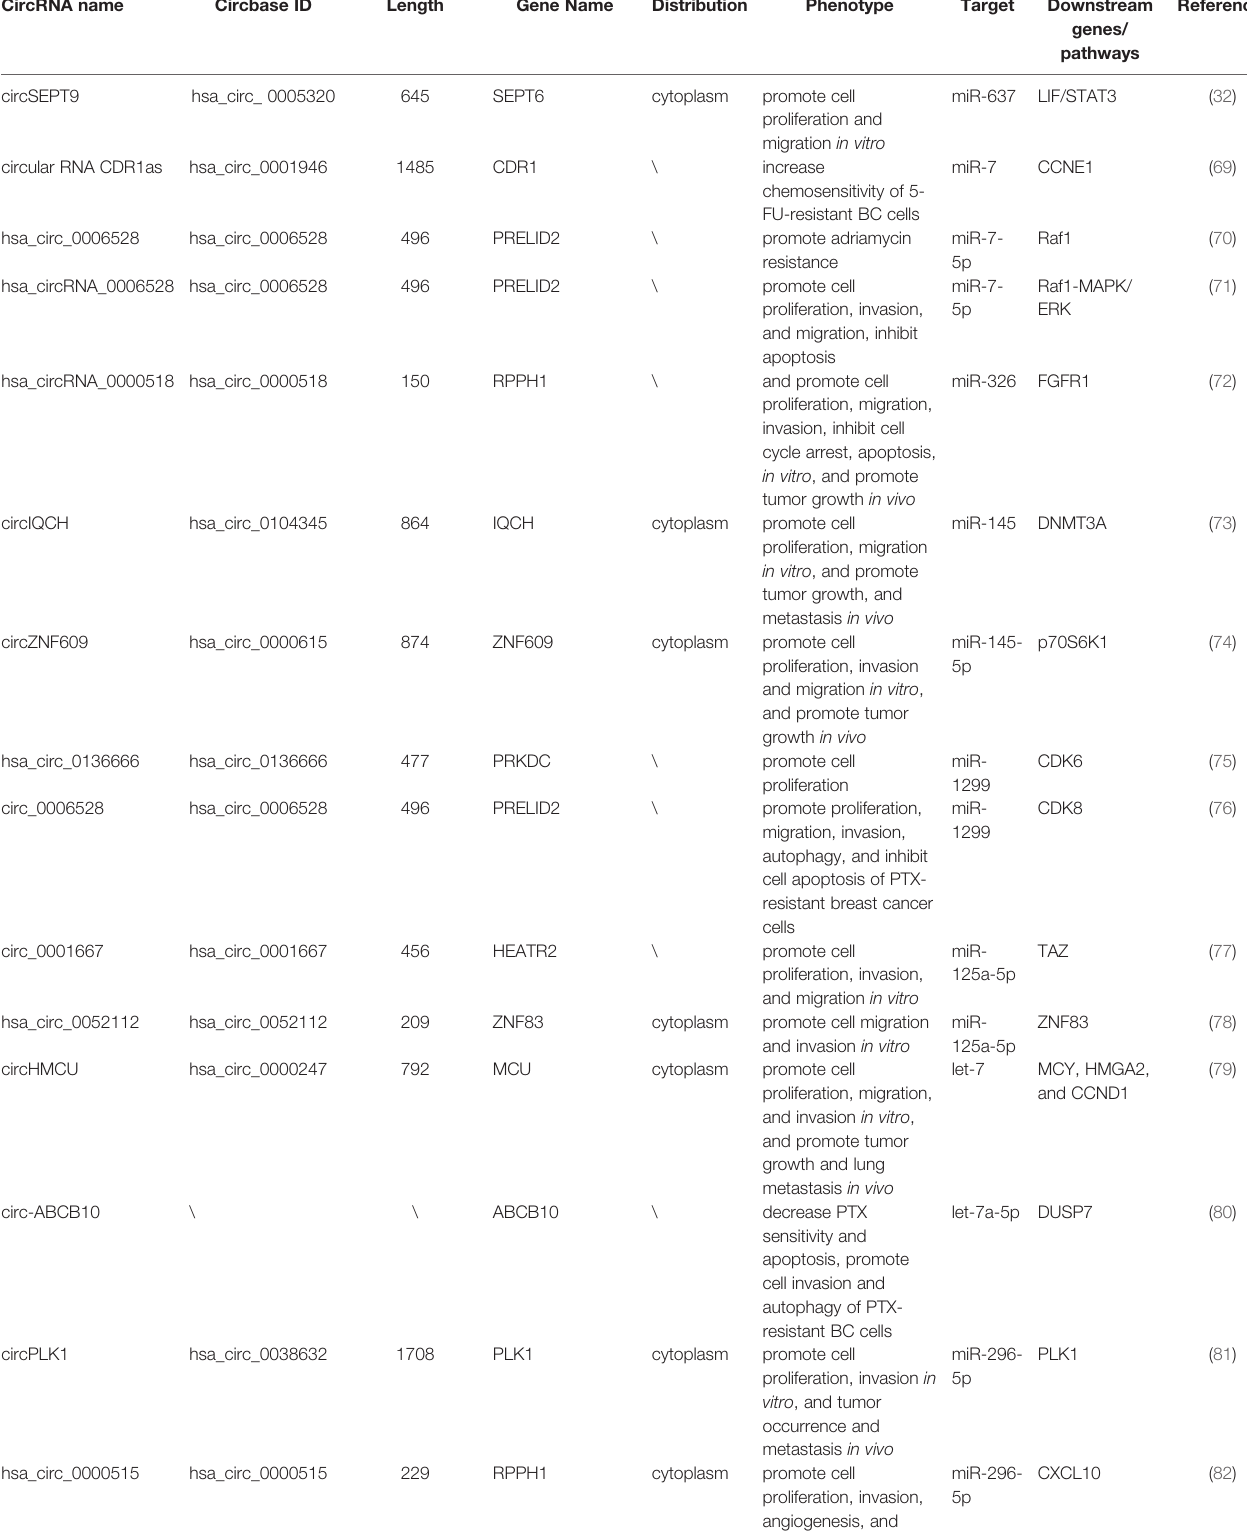
TABLE 2 | CircRNAs that play oncogenic roles in breast